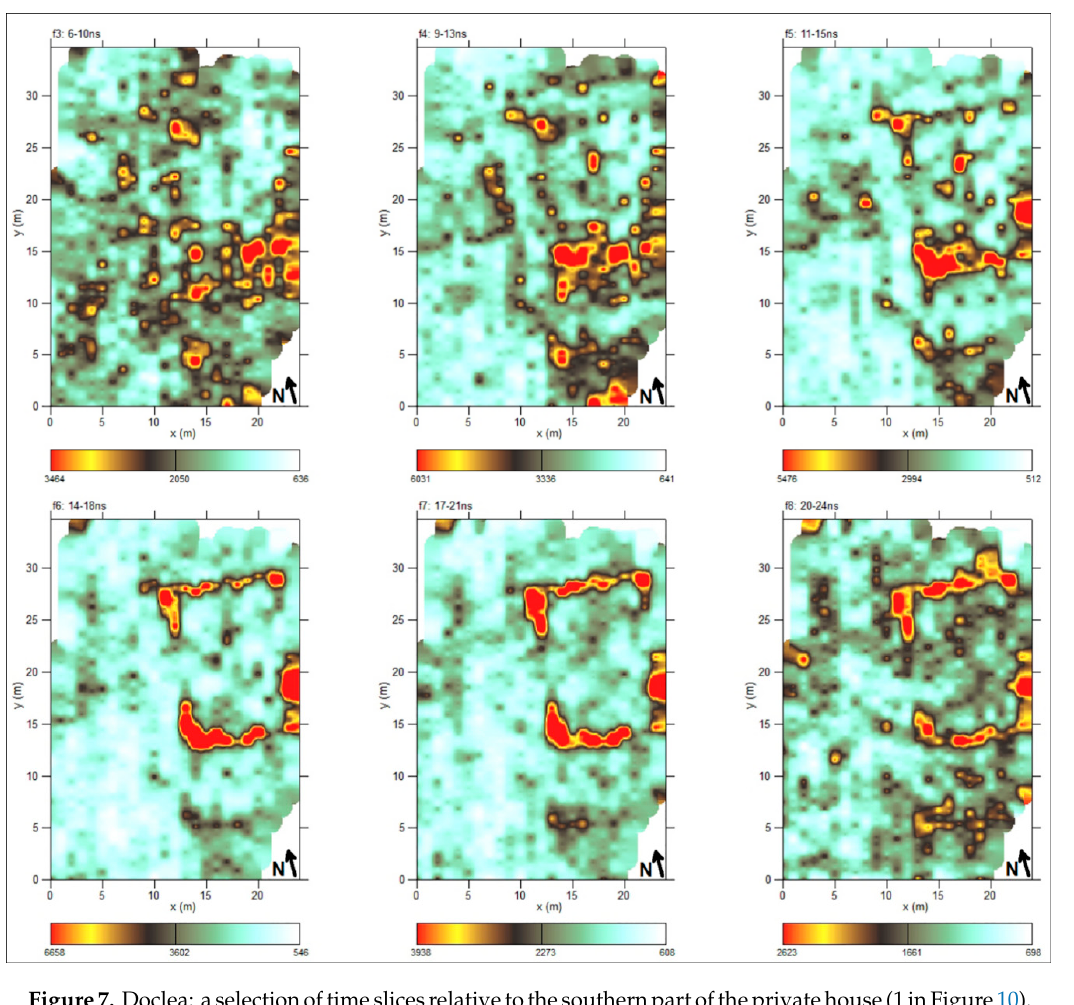
Figure 6. Doclea: the forum ( a ), the civil basilica ( b ) and some details of architectural elements ( c , d ). Recently the Centre for Archaeological Research of Montenegro, the Museum of Podgorica and different international Universities and Centres of Research restarted research activities [67–74].